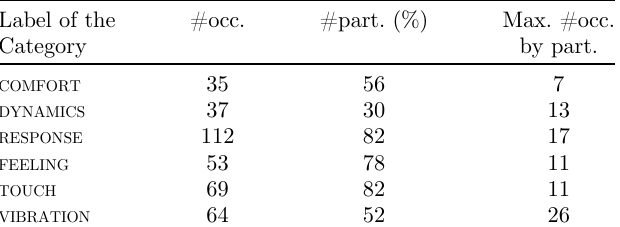
Table 3. Number of occurrences (abbr. #occ.) of each category, percentage of participants having used the words from each category (%, abbr. #part.), and maximum number of occur- rences for a single participant (abbr. Max. #occ. by